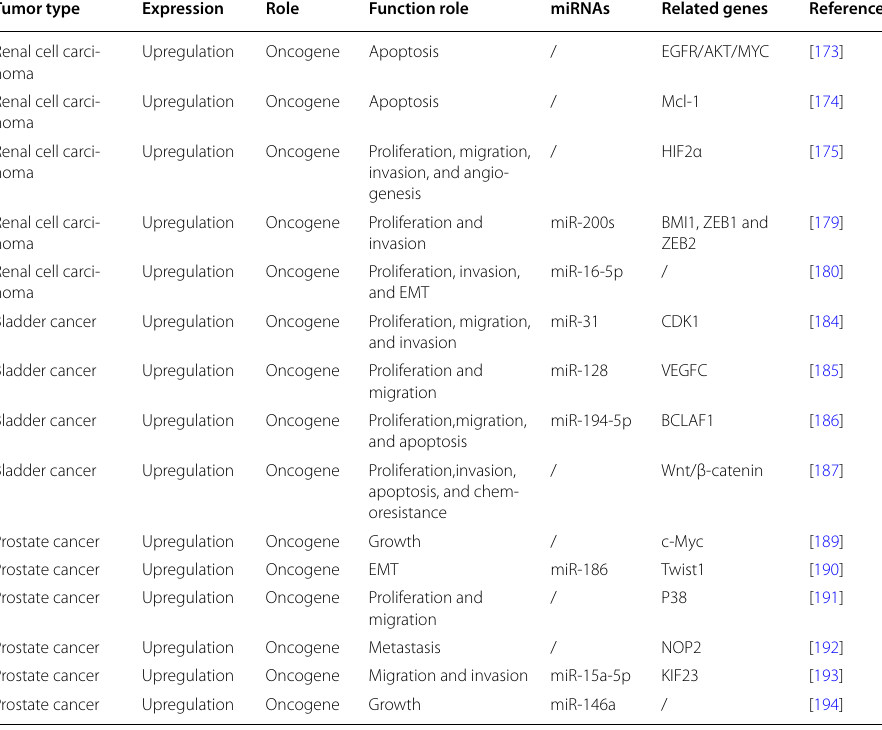
Table 7 Functional characterization of PVT1 in urinary system tumors Tumor